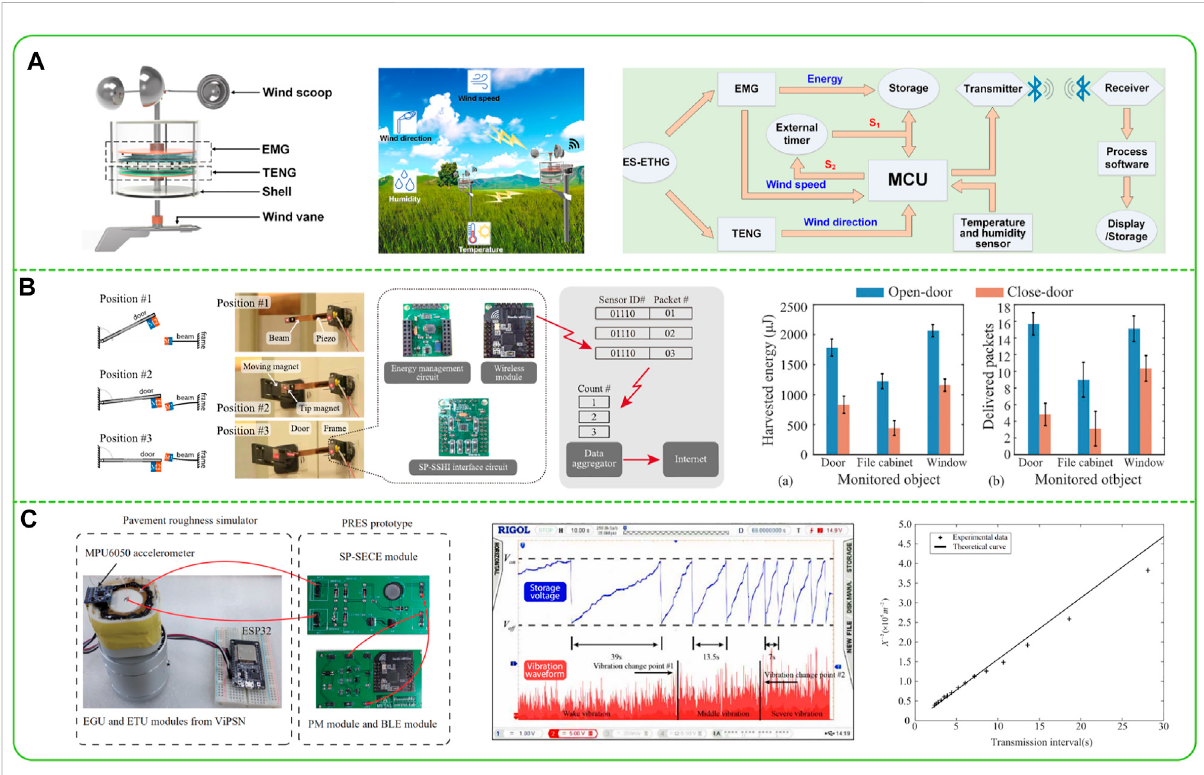
FIGURE 10 Self-powered sensor based battery-free IoT systems. (A) Schematic con fi guration of ES-ETHG, conceptual diagram, and systematic structure of the proposed system (Zhang et al., 2021). (B) Architecture and performance of ViPSN-pluck (Li et al., 2021b). (C) Experimental setup and results of BF-PRES (Hailiang Yang, 2022).